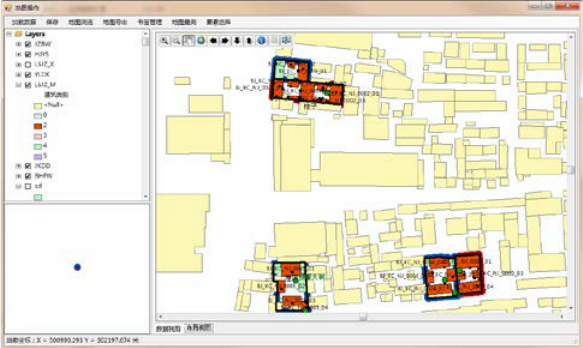
Figure 4 PC-side Data Management Tool